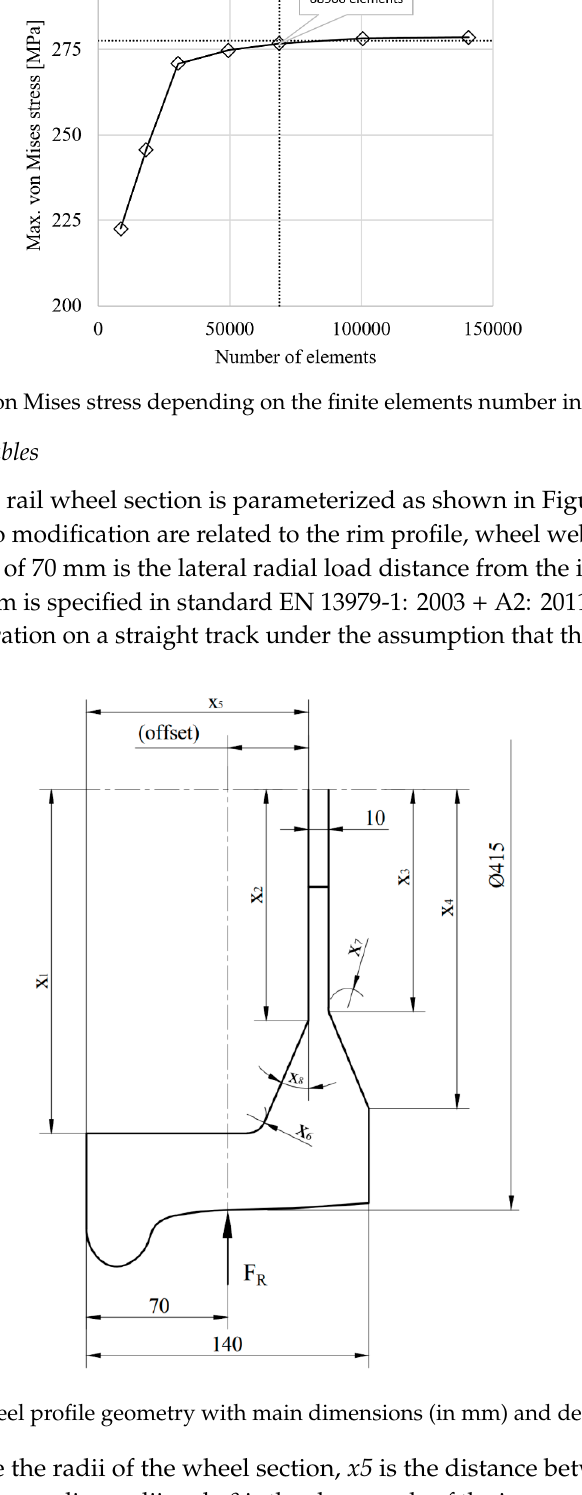
Table 3. Design variables (in mm).